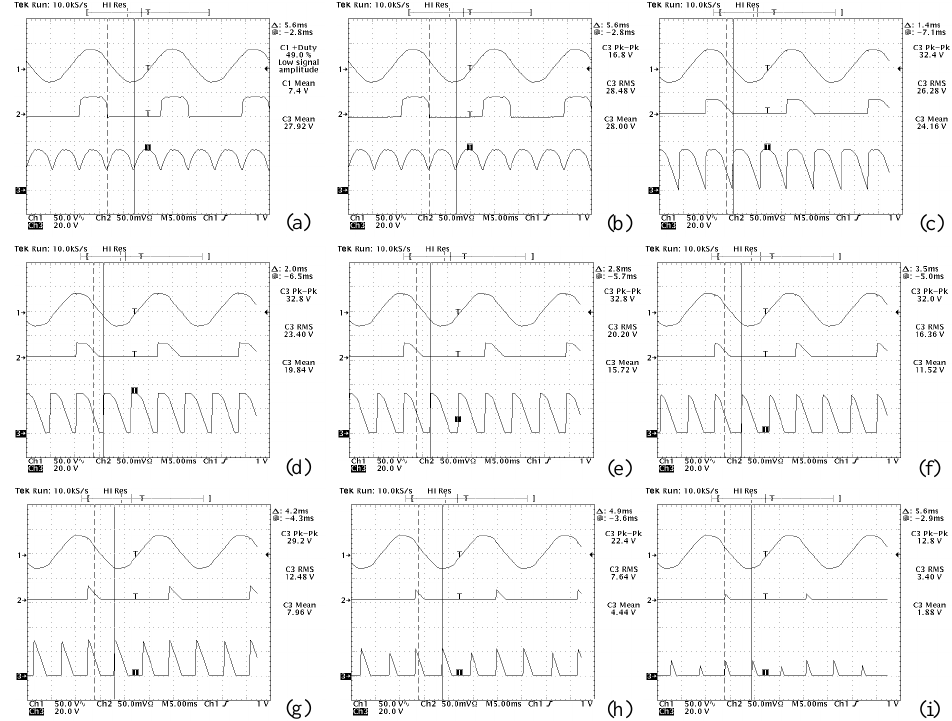
Figure 14. Experimental results for three-phase full-wave rectification: ( a ) firing angle α = 0 ◦ ( b ) α = 15 ◦ ( c ) α = 30 ◦ ( d ) α = 45 ( e ) α = 60 ◦ ( f ) α = 75 ◦ ( g ) α = 90 ◦ ( h ) α = 105 ◦ ( i ) α = 120